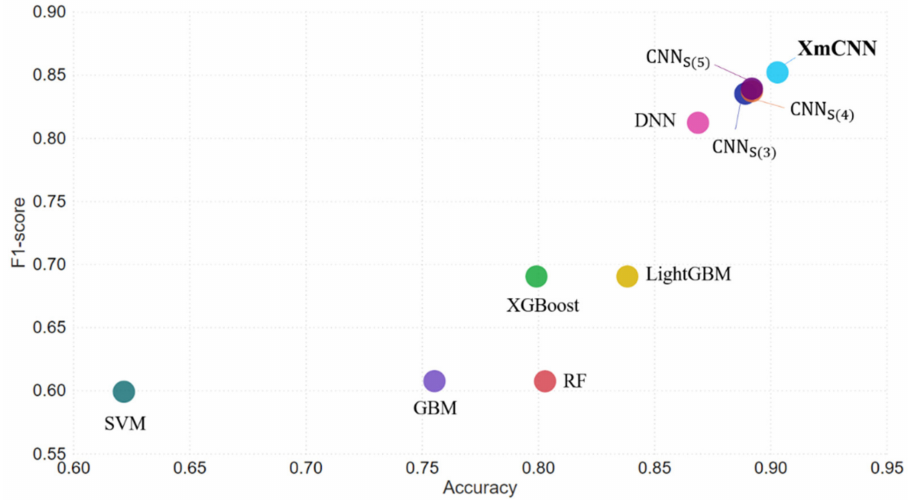
Figure 5. Performance comparison of the overall